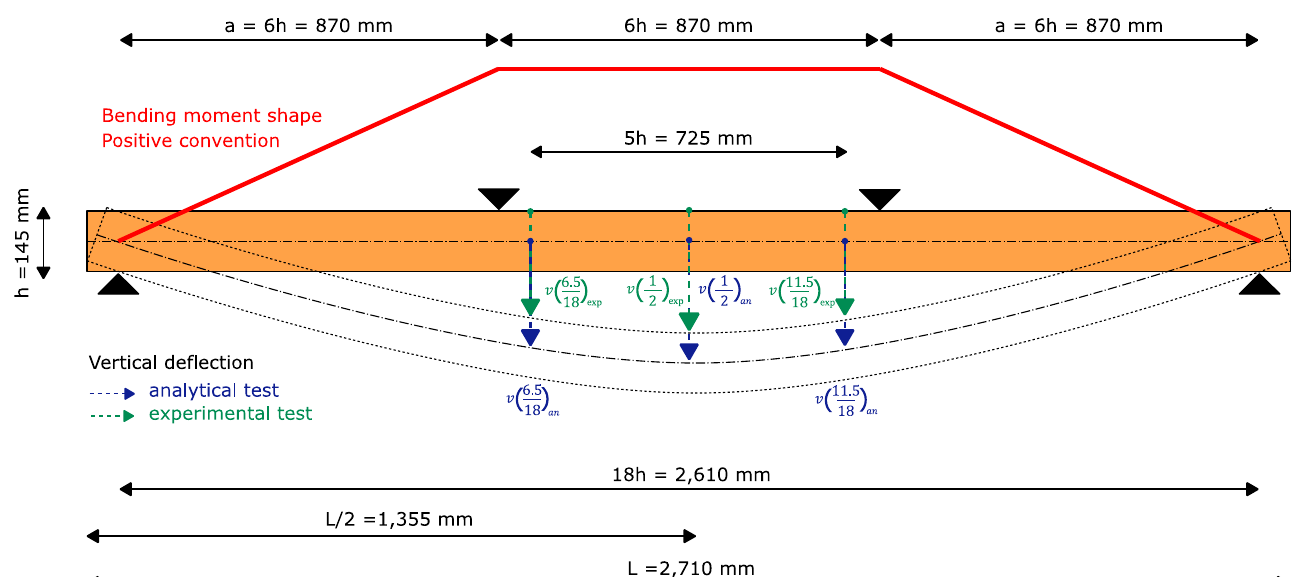
Figure 5. Four ‐ point bending test arrangement. Figure 5. Four-point bending test